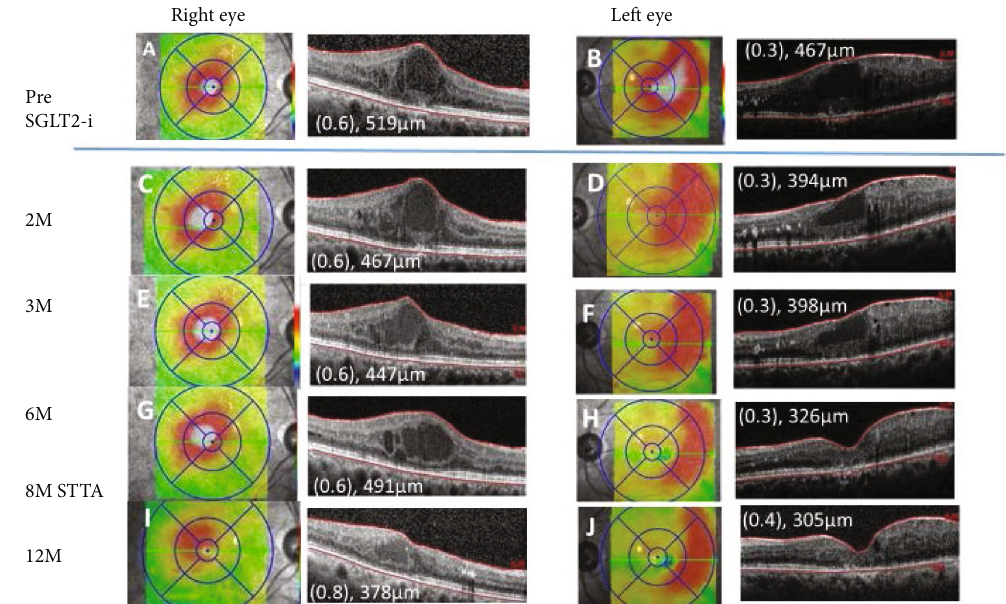
Figure 2: Case 2. Optical coherence tomographic images and fundus photographs showing the central retinal thickness (CRT) pre (A, B) and at 2 months (M) (C, D), 3 M (E, F), 6 M (G, H), and 12M (I, J) after commencing the oral sodium-glucose cotransporter 2 inhibitor (SGLT2i). A sub-Tenon injection of triamcinolone acetonide (STTA) was administered in her right eye at eight months.